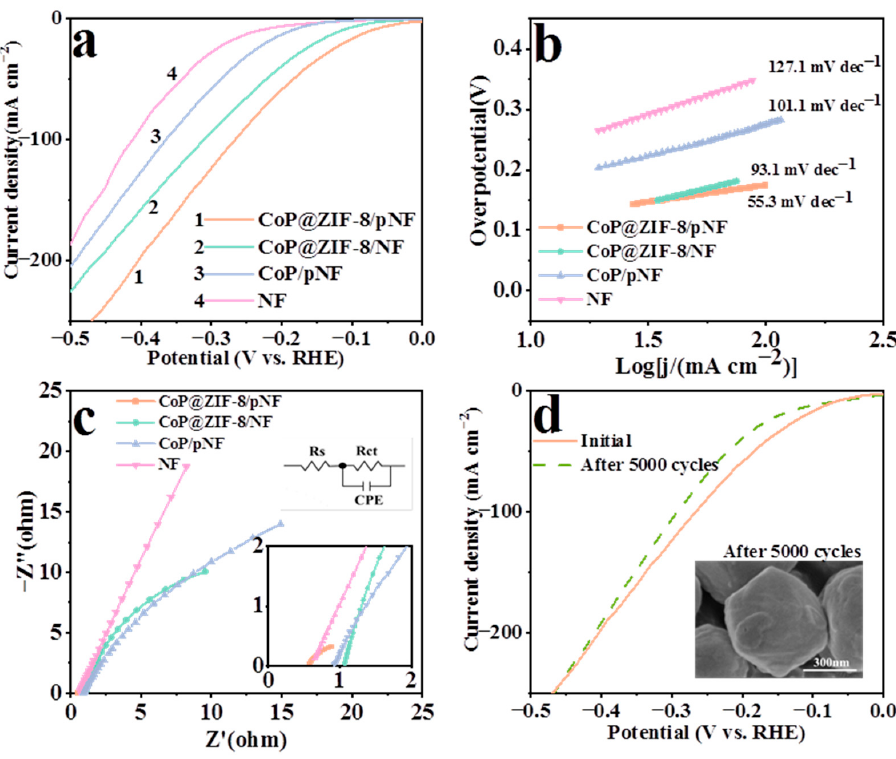
Figure 8. LSV curves ( a ), the corresponding Tafel plots ( b ) and EIS test ( c ) for HER of CoP@ZIF-8/pNF, CoP@ZIF-8/NF, CoP/pNF and bare NF in 1.0 M KOH. ( d ) LSV for HER of CoP@ZIF-8/pNF after 5000 CV